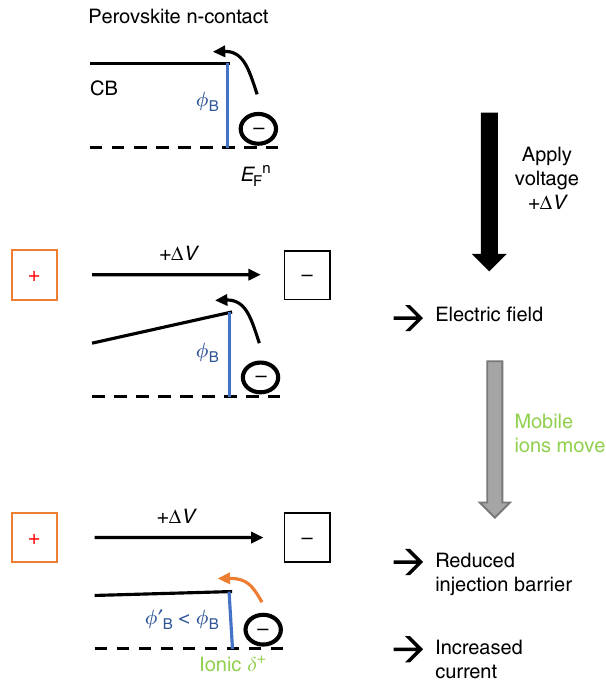
Fig. 8 Sketch explaining ion-enhanced charge-carrier injection at the contact. Here the n-side is shown. An analogous picture can be drawn for the p-side. Ion redistribution upon increasing the voltage by Δ V changes the injection barrier ϕ B . More positive net ionic charge leads to a surface dipole that decreases ϕ B . This effect enhances the current, which appears as a negative